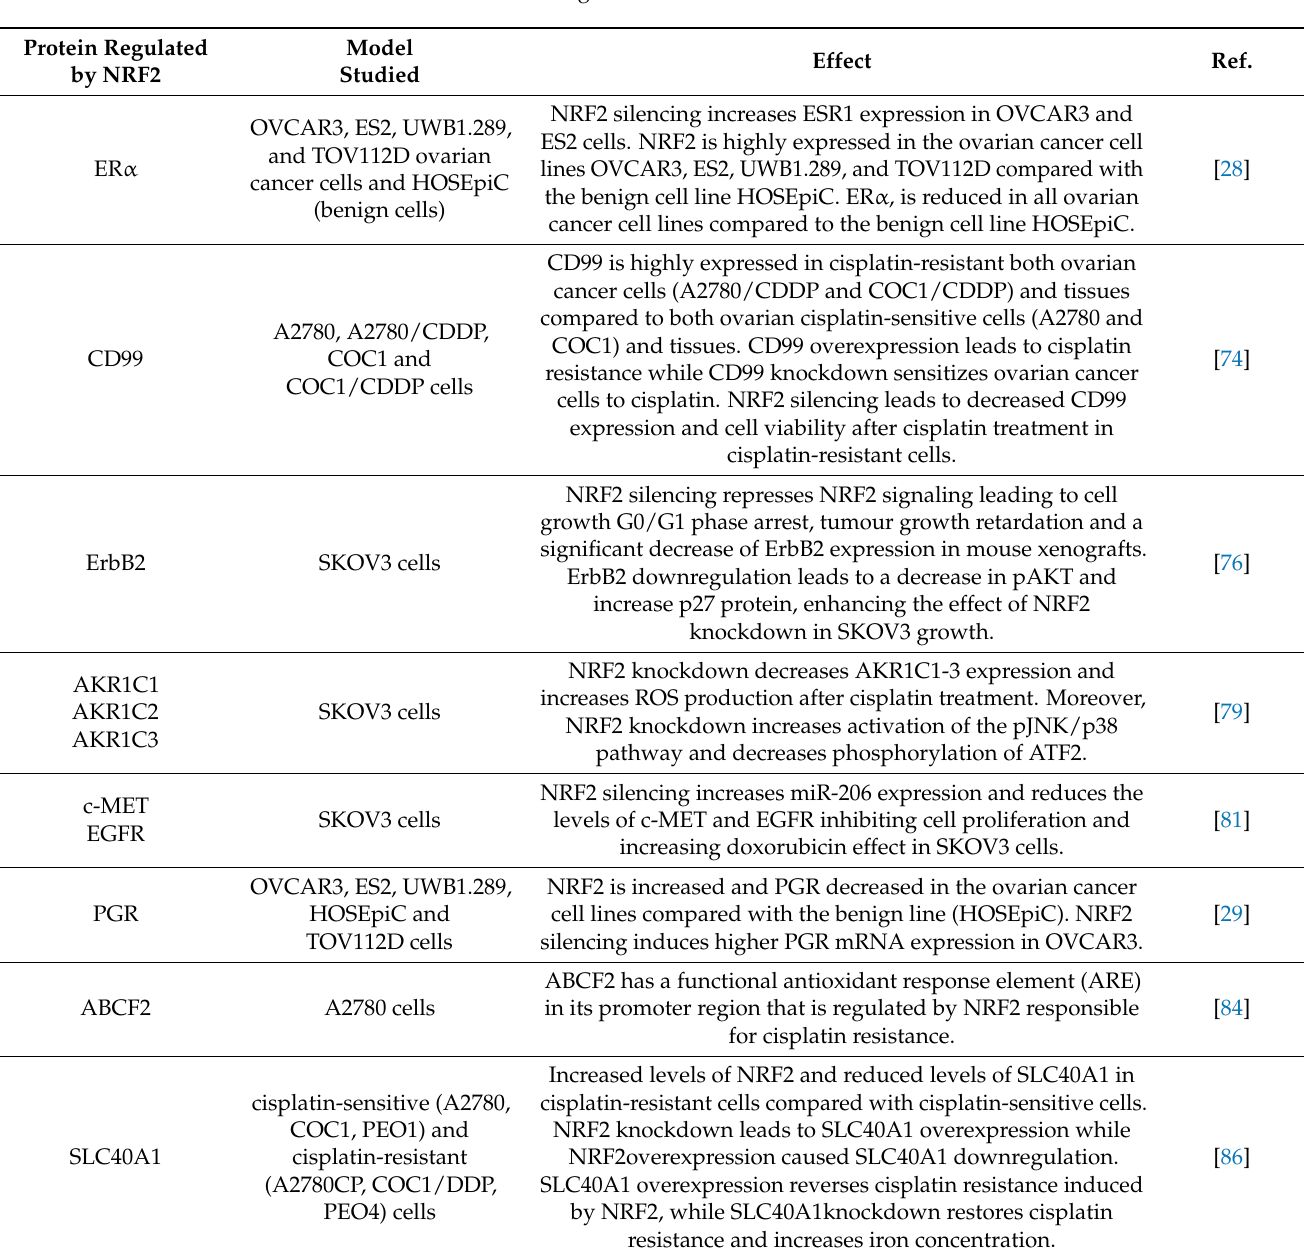
Table 3. NRF2 cellular targets in ovarian